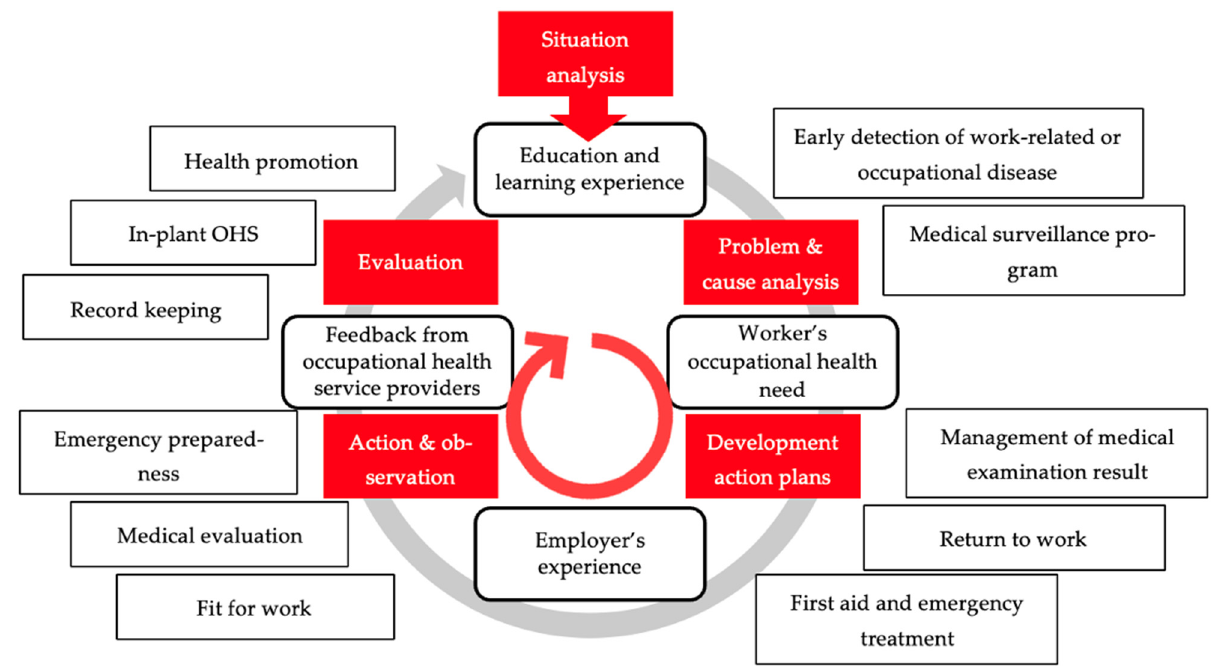
Figure 3. The cycle of participatory action research for developing occupational health